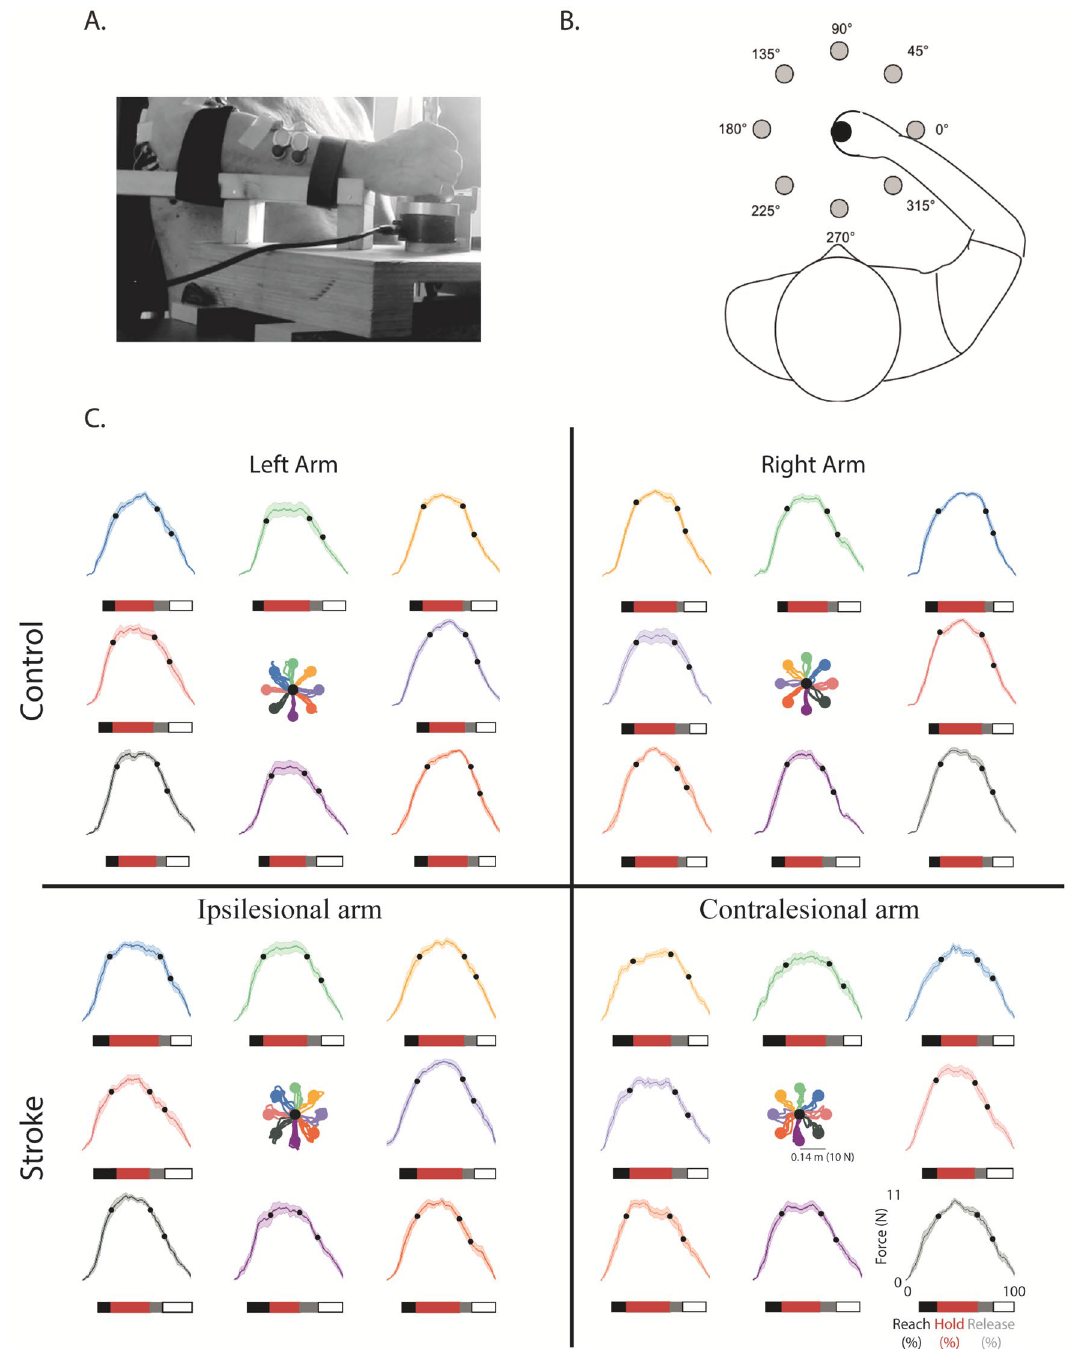
Figure 1. Top Panels: Experimental set-up. Subjects sat in front of a computer screen holding a force sensor with their forearm resting on a custom-made support that prevented their motion ( A ). Subjects controlled the movement of a cursor on the screen applying isometric forces with their hand. They had to reach targets at 14 cm distance, corresponding to 10 N force, in 8 different directions ( B ). Bottom panel ( C ): Cursor trajectories and force profiles for the left (first column) and by right (second column) hand of a control subject (first row), and for the ipsilesional and contralesional hand of a stroke subject (second row). We considered equivalent directions that corresponded in joint coordinates and the left-arm forces (and corresponding cursor trajectories) were mirrored at the midline in the endpoint space. Colors indicate equal directions in the endpoint space. The black dots on each force profile represent the transition points between each phase of the force exertion (cursor movement). The colors of the bars below each profile referred to these phases: (black) reaching phase where the applied force increased from 0 to 10 N corresponding to the center-out movement of the cursor; (red) holding phase where that reached force level was maintained corresponding to keeping the cursor inside the target; (gray and white) force release—grey the force decrease from 10 to 5 N, white from 5 to 0 N corresponding to the out- center movement of the